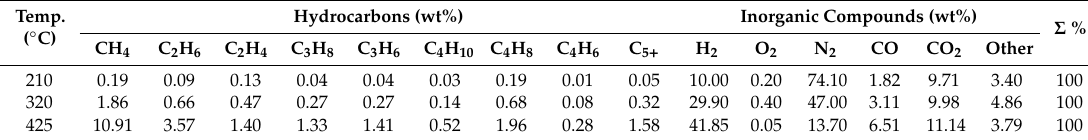
Table 6. Gas composition, postconsumer material, 425 ◦ C.